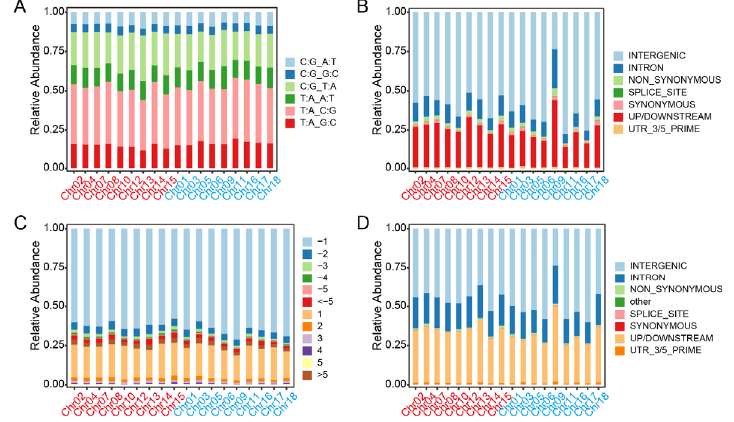
Figure 7. The shared SNPs and INDELs in Longli-4 and CA3-1. ( A ) SNP variations including transitions and transversions are categorized into six groups, and the percentage of each group on each chromosome is shown as a stacked bar. ( B , D ) SNPs ( B ) and INDELs ( D ) are classified into seven groups based on annotation, and percentages of the seven groups on each chromosome are shown as a stacked bar. ( C ) INDELs including insertions and deletions are classified into twelve groups according to the reference genome information, and percentages of the twelve groups on each chromosome are stacked as 100%. The chromosomes from the A and B sub-genomes of quinoa are shown as those in Figure